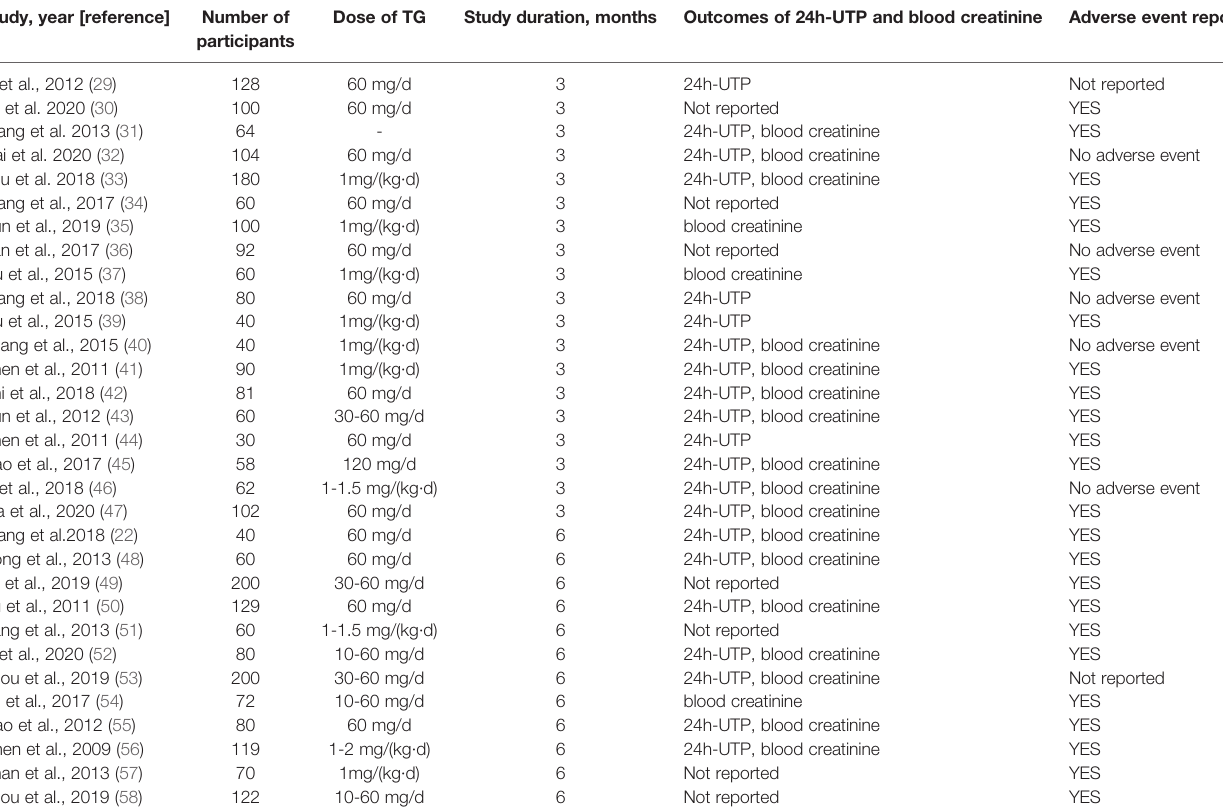
TABLE 1 | Characteristics of studies and participants included in systematic review and